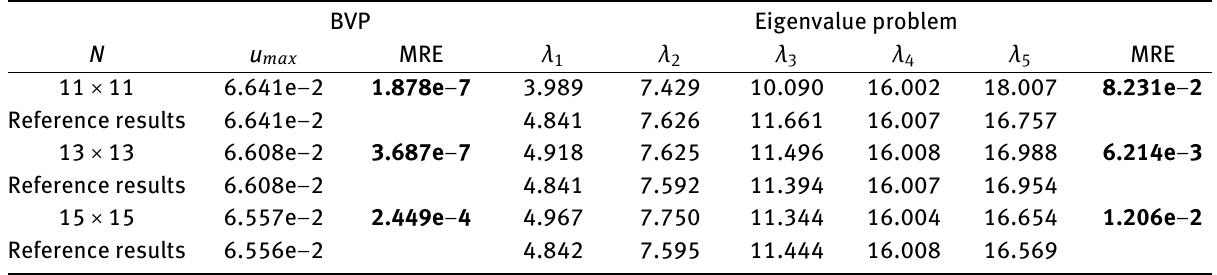
Table 3: The results from solving the biharmonic problems on the quarter section of the elliptical domain. The boundary conditions given by Eq. (29) implemented using strategy